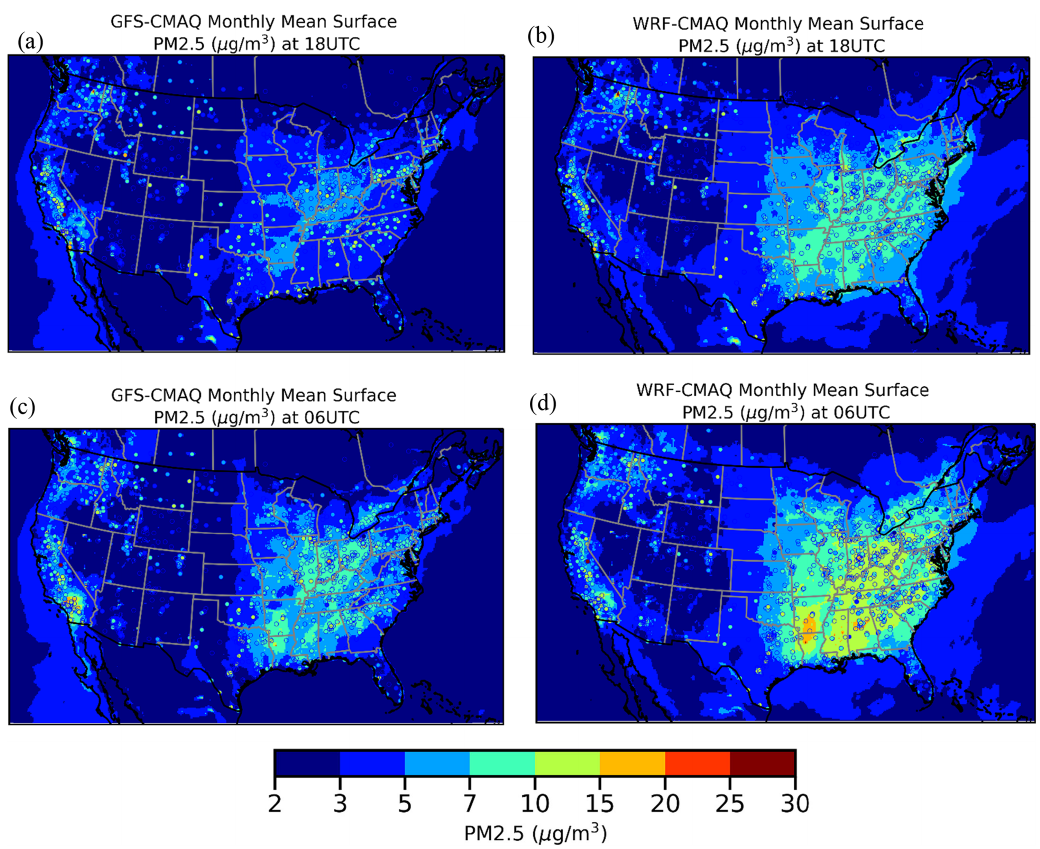
Figure 6. Same as Fig. 5 but for surface PM 2 . 5